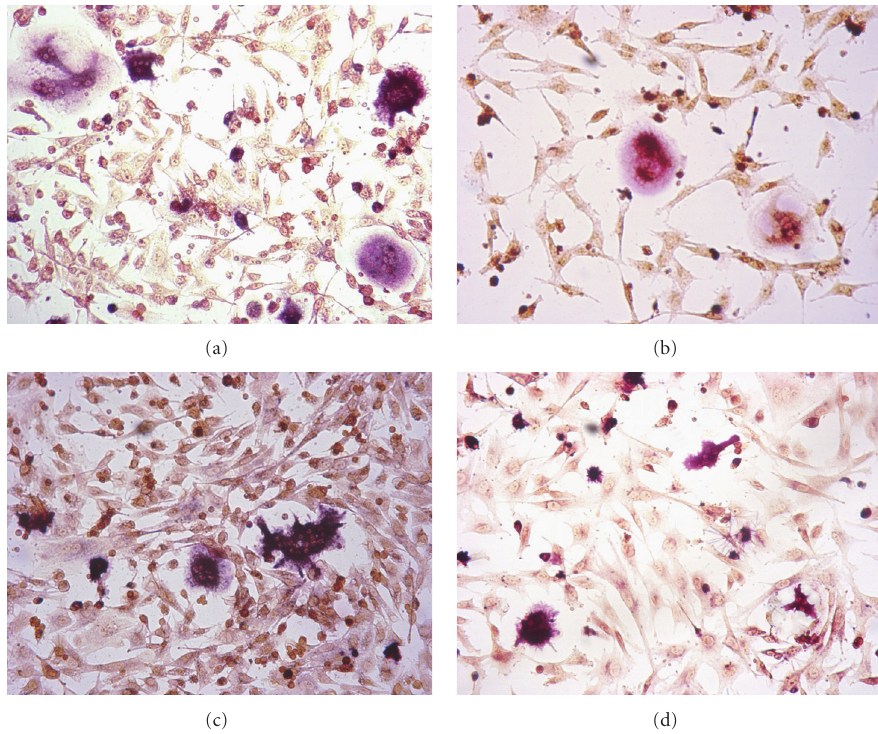
Figure 3: Primarily isolated osteoclasts cocultured with nontransfected (a) and pCDNA3.0-transfected (b), pCDNA3.0-Ig κ -hCT-transfected (c) NIH3T3 cells and nontransfected NIH3T3 cells plus sCT (d). TRAP staining shows that primarily isolated osteoclasts are multinucleate and spreading cells, which become crumpled when cocultured with pCDNA3.0-Ig κ -hCT-transfected.